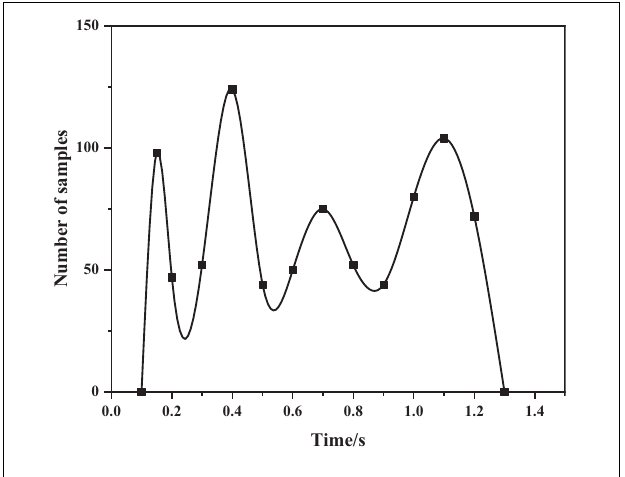
FIGURE 5 | Pitch frequency of happy